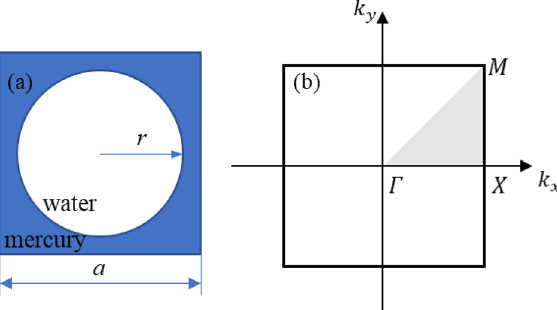
Figure 1. PnC unit cell structure, where ( a ) is PnC unit cell and ( b ) is irreducible brillouin zones and high symmetry